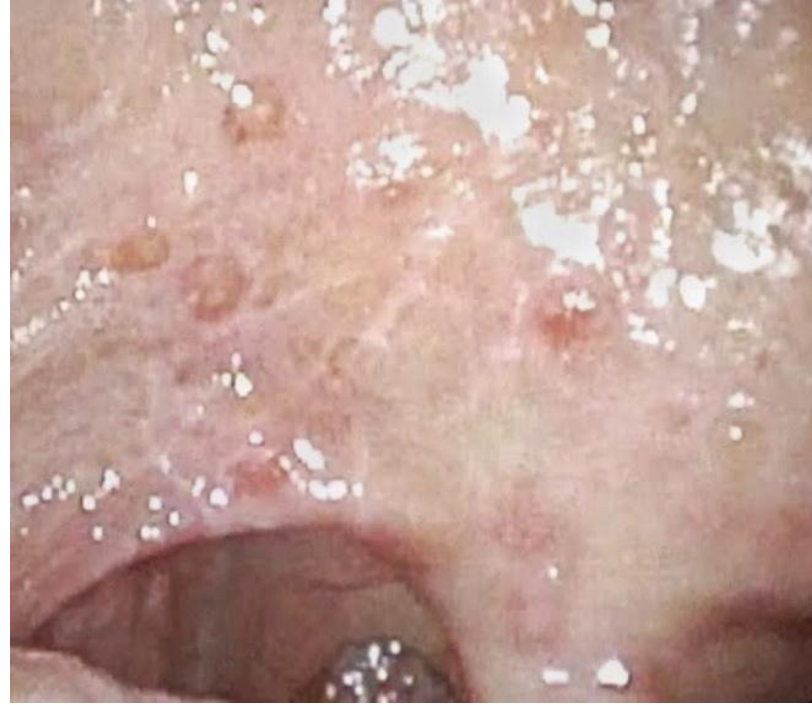
Figure 1. Oral mucositis with blisters.